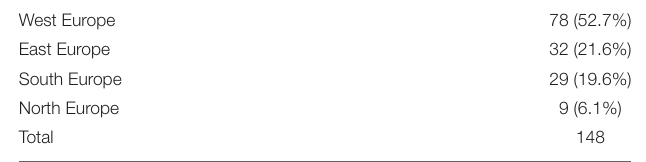
TABLE 7 | Cases per region a